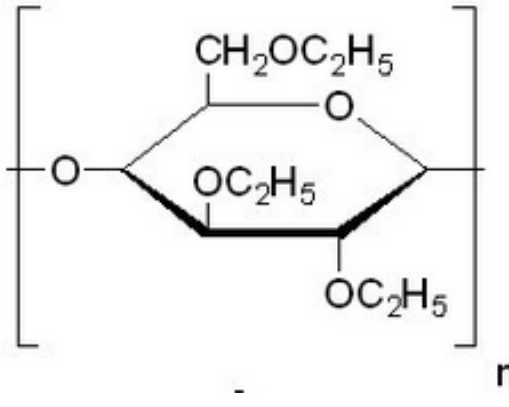
Figure 4. Represents the chemical structure of EC [46].